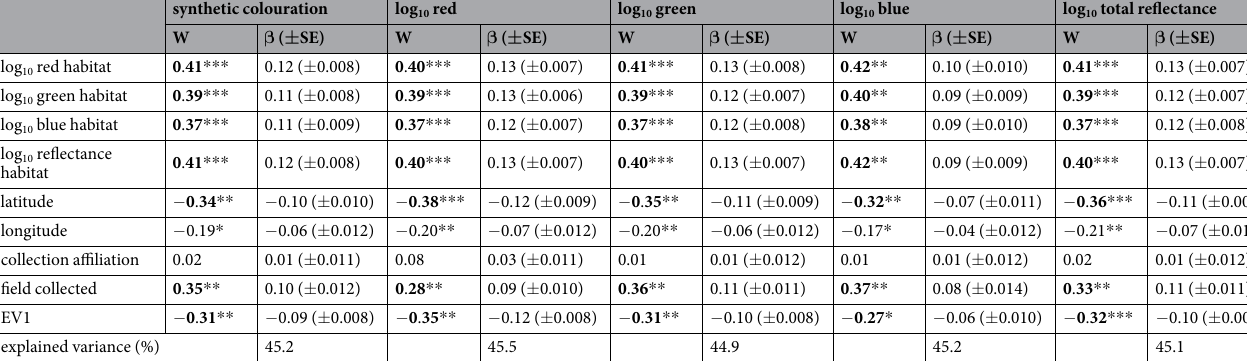
Table 1. Partial least squares regression (PLSR) analyses results for dorsal fur colour (synthetic colouration includes RGB colours and total reflectance variables) and habitat colouration, geographic coordinates, field/ collection affiliations and phylogenetic eigenvectors for Gerbillus rodents from Sahara-Sahel region. Significance levels of regression coefficients of predictors: *** < 0.001, ** < 0.01, * < 0.05. EV1 – eigenvector 1 from phylogenetic vector regression (PVR) models. Explained variance (%) in the response variables depicted by the PLSR models. W, the weights of predictors’ contribution of variables to PLSR models, explaining more than 5% of the total variance are indicated in